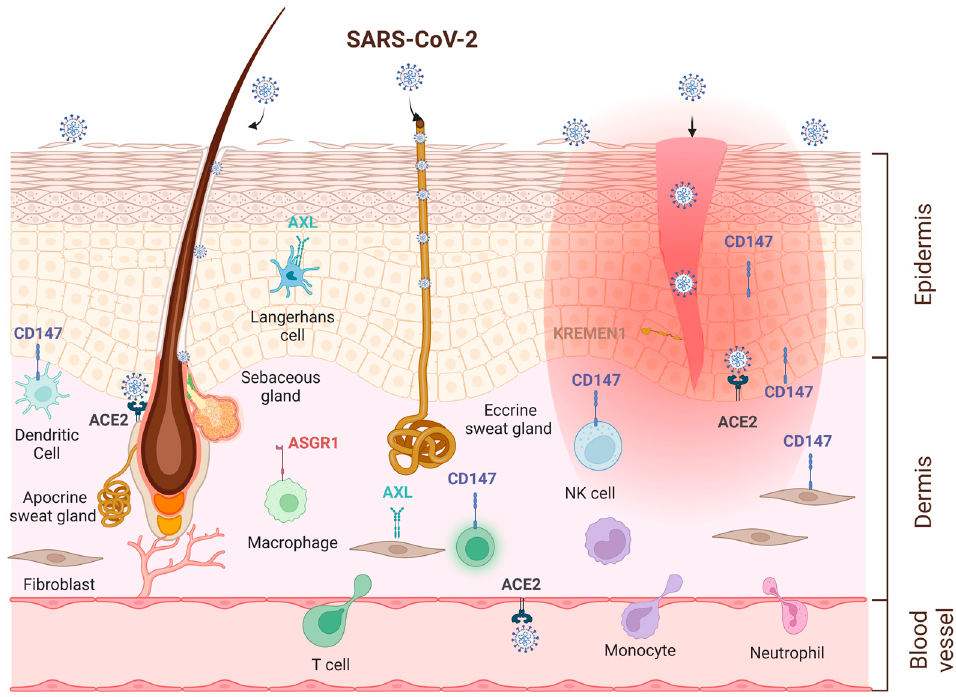
Figure 3. Possible routes of entry of SARS-CoV-2 virus in human skin: direct viral entry via skin lesions, sweat ducts or hair follicles or indirectly by deposition of circulating virus.